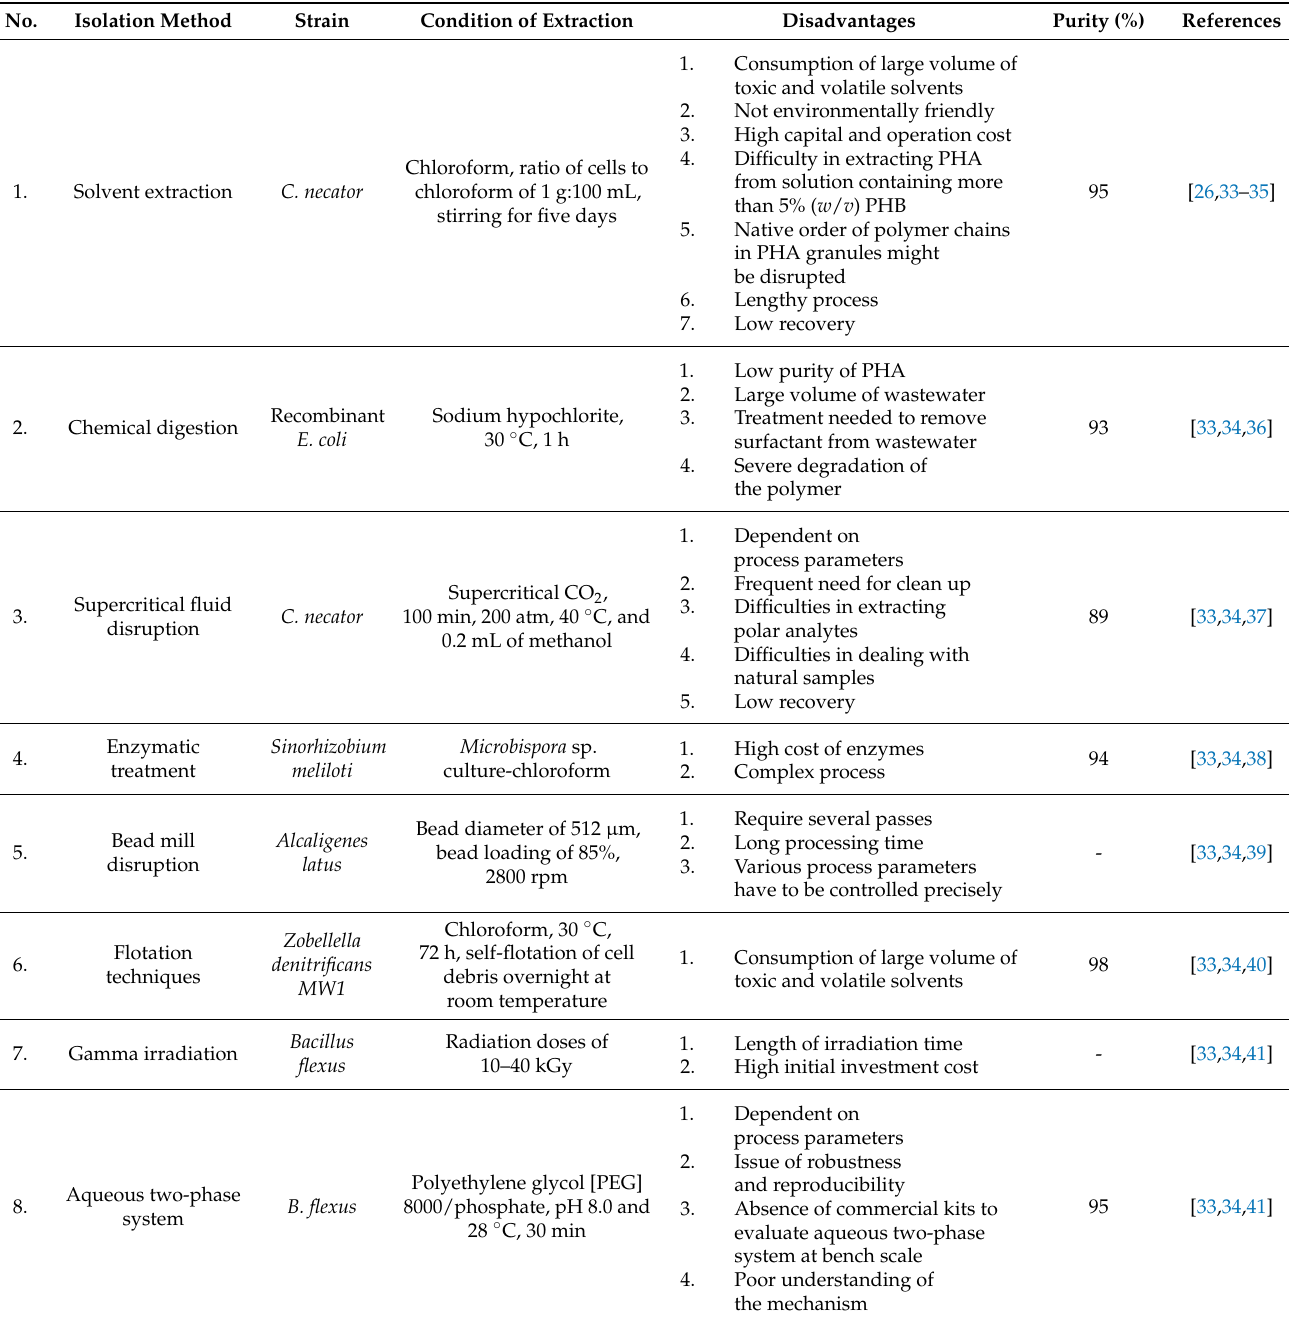
Table 1. Condition of conventional polyhydroxyalkanoate (PHA) extraction